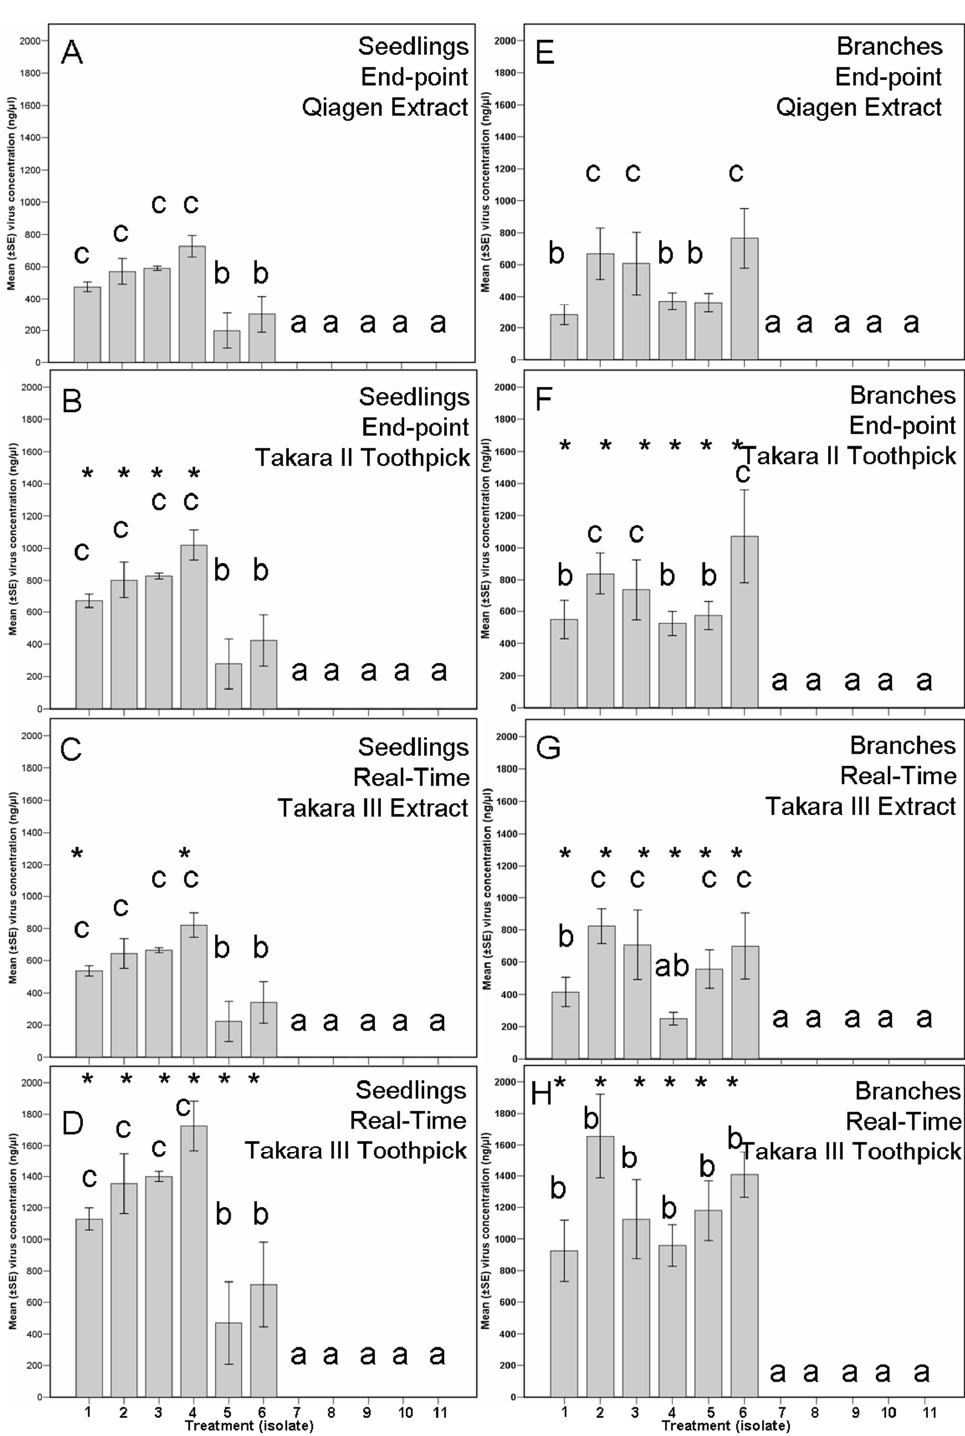
Figure 5. Virus concentration within the re-isolations after 53 days post individual inoculation (assay I, ( A – D ) using seedings, ( E – H ) using branch segments) with ten isolates of Cryphonectria parasitica (1–3 infected with the hypovirus CHV1-M2273, 4–6 infected with CHV1-M2357, and 8–11 virus-free isolates) and a PDA control (number 7). (Eleven treatments). Bars with the same letter are not significantly different based on a Tukey (cid:48) s test. ( A ) Seedlings ( n = 44). ( B ) Branch segments ( n = 33). Bars with an asterisk indicate significant differences against the same isolate treatment analysed using the Qiagen Extract End-point PCR method for the CHV-1